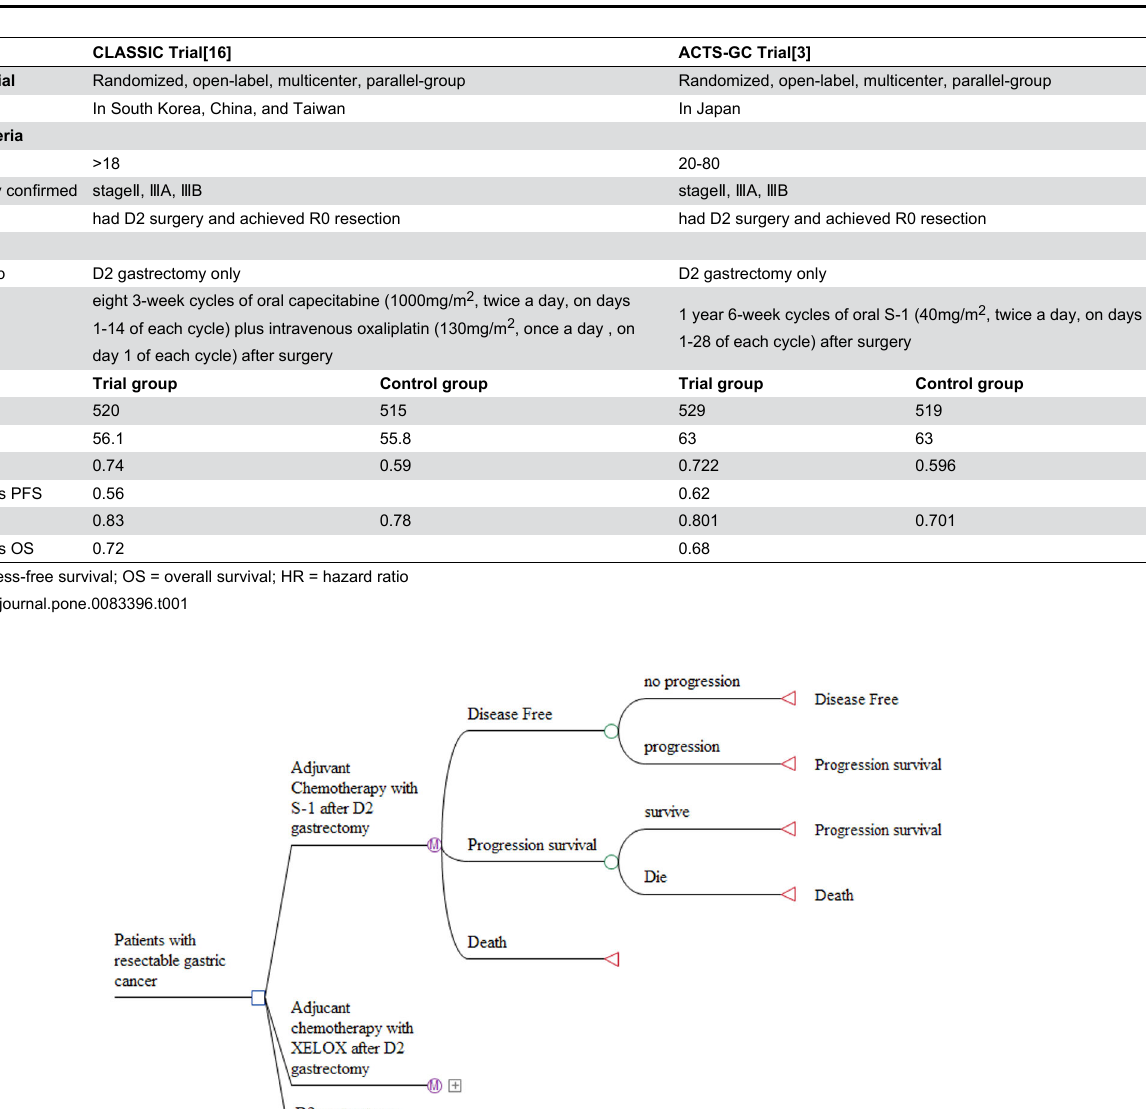
Table 1. Compared with CLASSIC and ACTS-GC Trials.